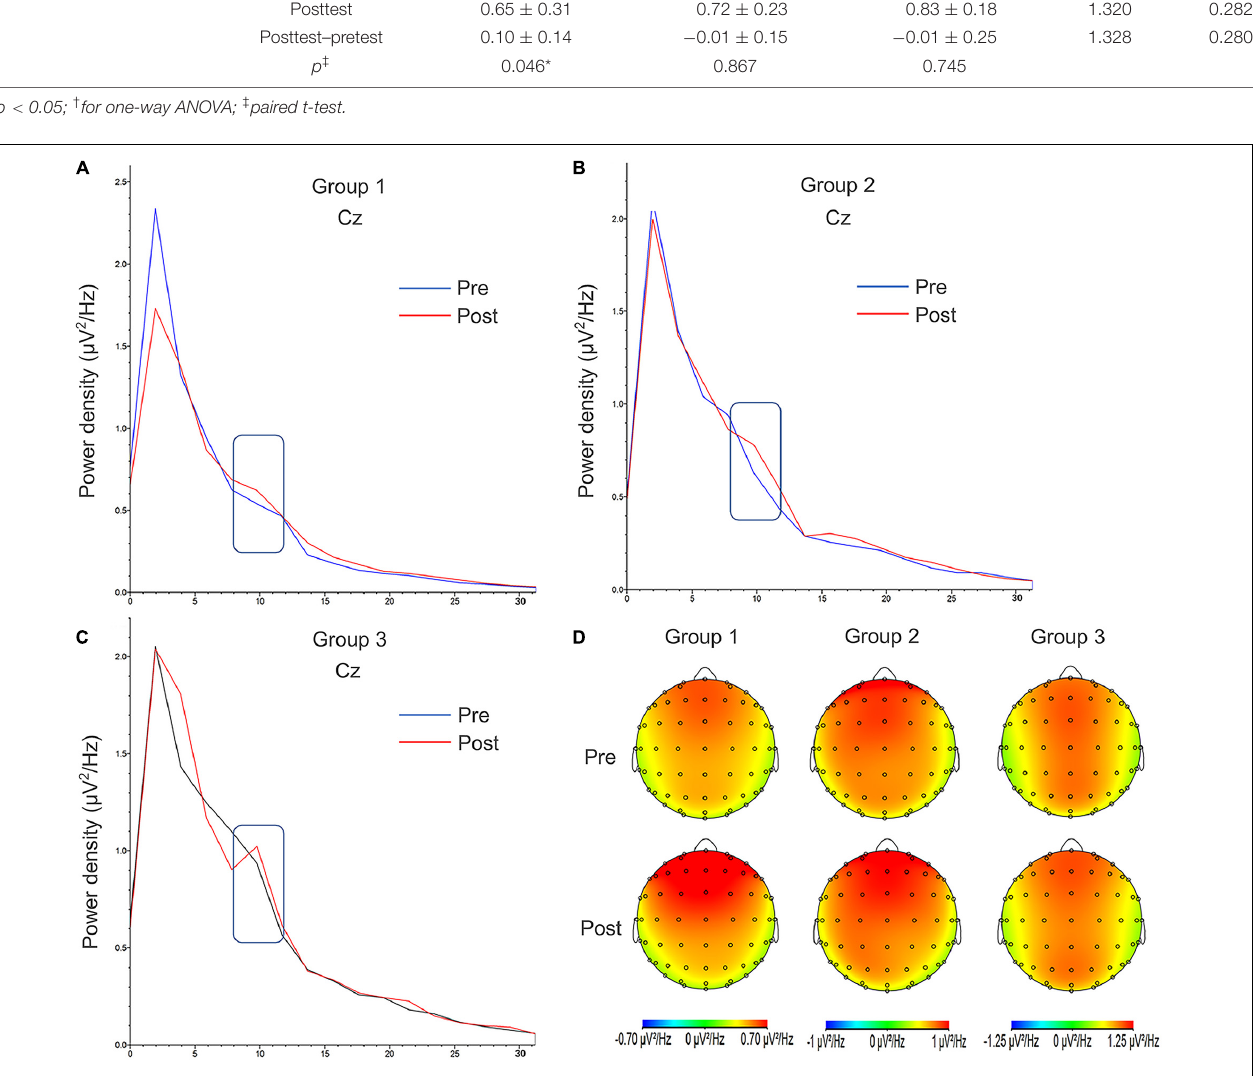
Frontiers in Neuroscience |